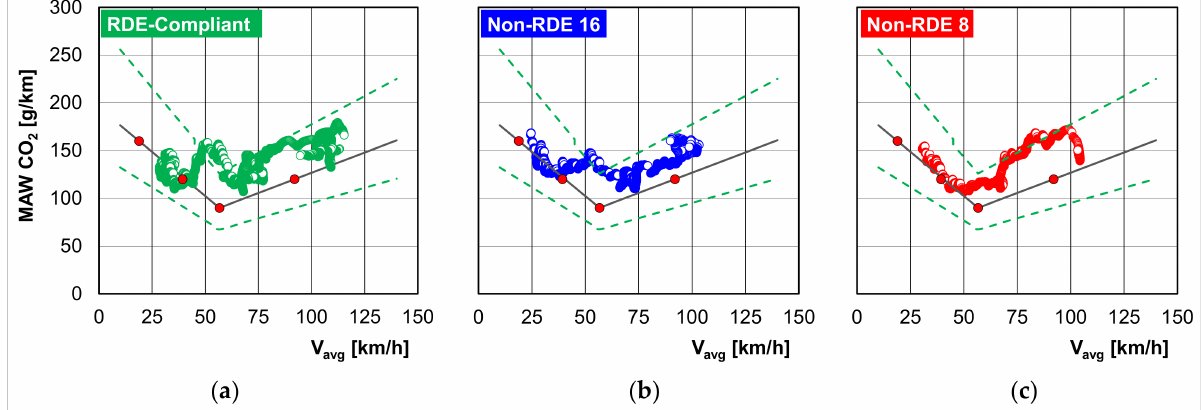
Figure 4. CO 2 road emission values in the measurement windows against the values in the different parts of the WLTC test (solid red dots) and acceptable tolerances (green dashed line): ( a ) RDE- Compliant; ( b ) RDE 16 km; ( c ) RDE 8